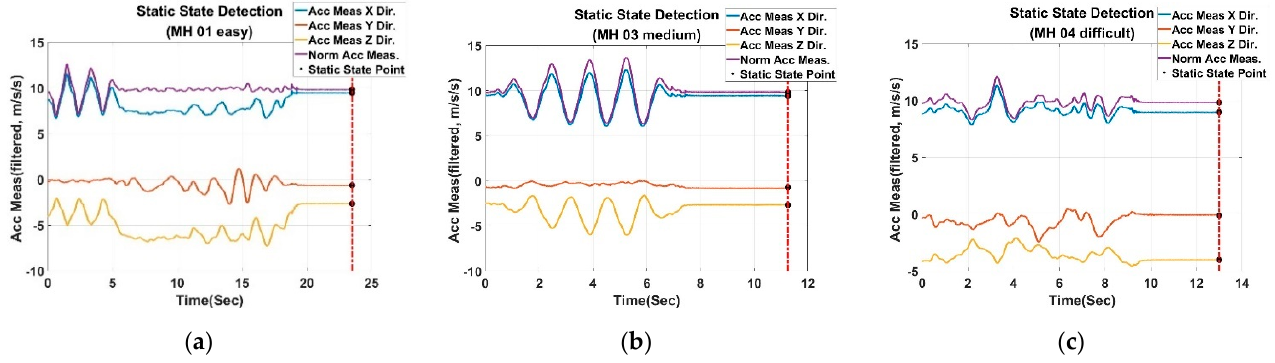
Figure 14. Flowchart of the proposed static state detection algorithm.